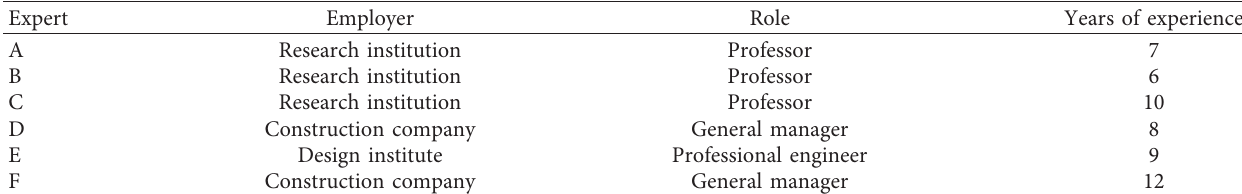
Table 1: Profile of experts.